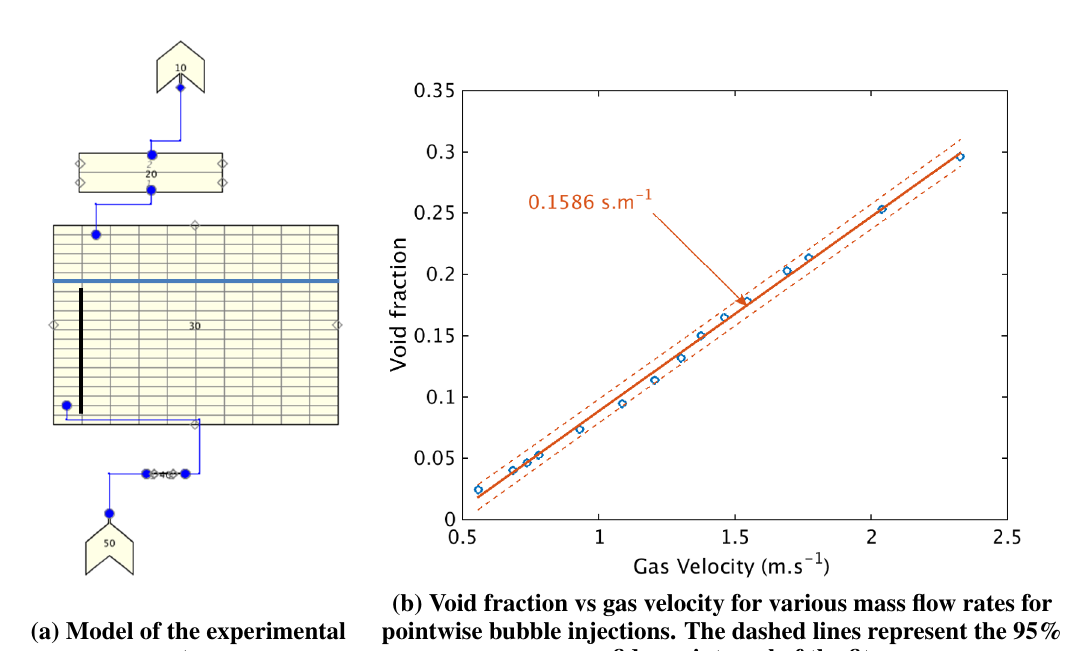
Figure 2: Calculation of the void content in the channel with TRACE